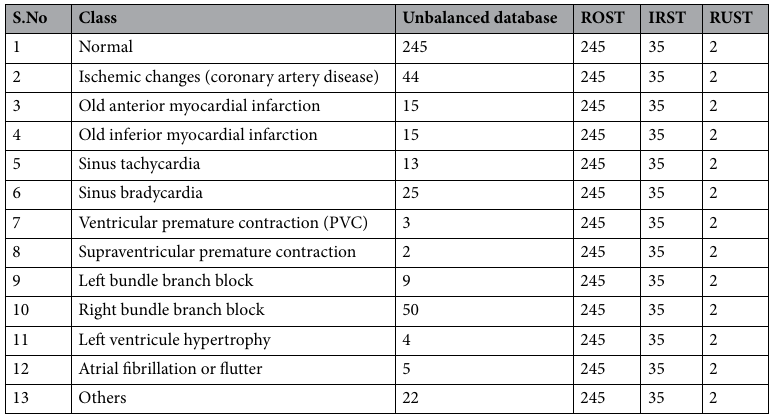
Table 5. Comparison of number of samples in the classes in balanced UCI repository arrhythmia corrected database with number of samples in the classes in unbalanced UCI repository arrhythmia corrected